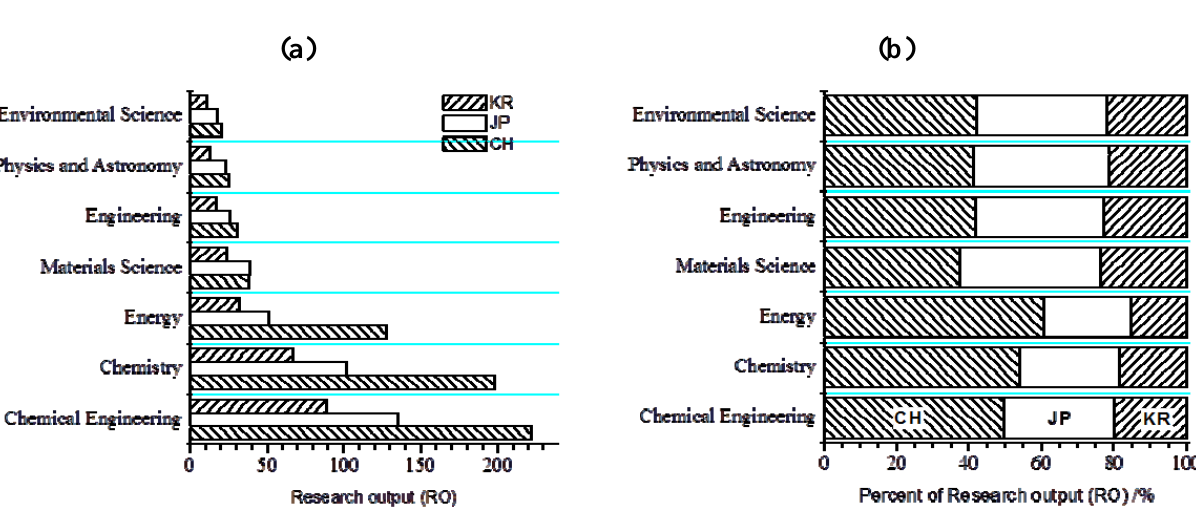
( b ) Percentage proportion of subject category distribution in China, Japan and Korea.